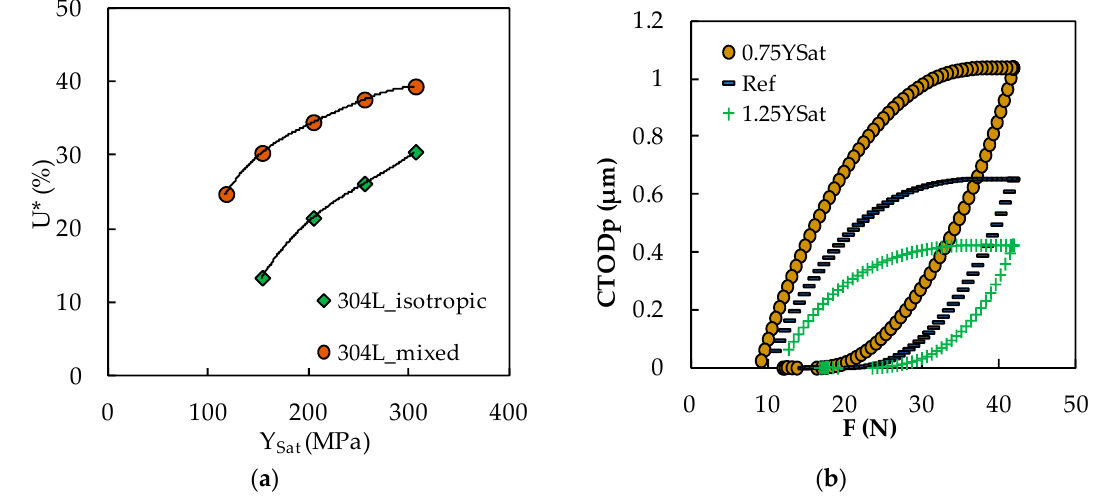
Figure 5. ( a ) CTOD vs. load; ( b ) plastic CTOD vs. load (SS304L isotropic; with crack closure).